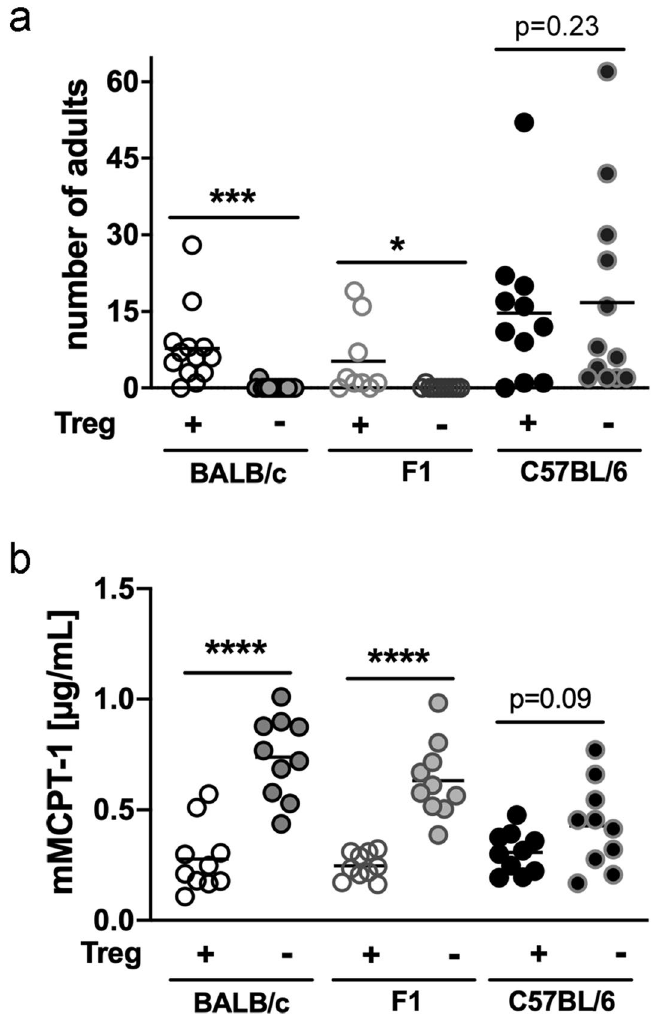
Figure 7. Depletion of Treg in F1 mice results in improved expulsion of S. ratti from the intestine. BALB/c DEREG, F1 DEREG and C57BL/6 DEREG mice and their littermates were infected with 2000 iL3 s.c. in the footpad. DEREG mice (− Treg) and their non-transgenic littermates (+ Treg) were treated with 0.5 µg DT one day prior to S. ratti infection and on the 2 following days. ( a ) Parasitic adults in the small intestine were counted at day 6. Shown are combined results from 3 experiments (BALB/c + /− Treg: n = 13; F1 + Treg: n = 9, F1 − Treg: n = 11; C57BL/6 + Treg: n = 11, C57BL/6 − Treg: n = 12). ( b ) Concentration of mMCPT-1 in the serum of day 5 infected mice. Each symbol represents the worm burden and the amount of mMCPT-1 from a single mouse. Horizontal lines represent the mean. Shown are combined results from 3 different experiments with n = 10 mice per group. Data were analyzed by unpaired t-test comparing mice with and without Treg from one genotype. Asterisks indicate significant differences of the mean (*p ≤ 0.05, ***p ≤ 0.001, ****p ≤